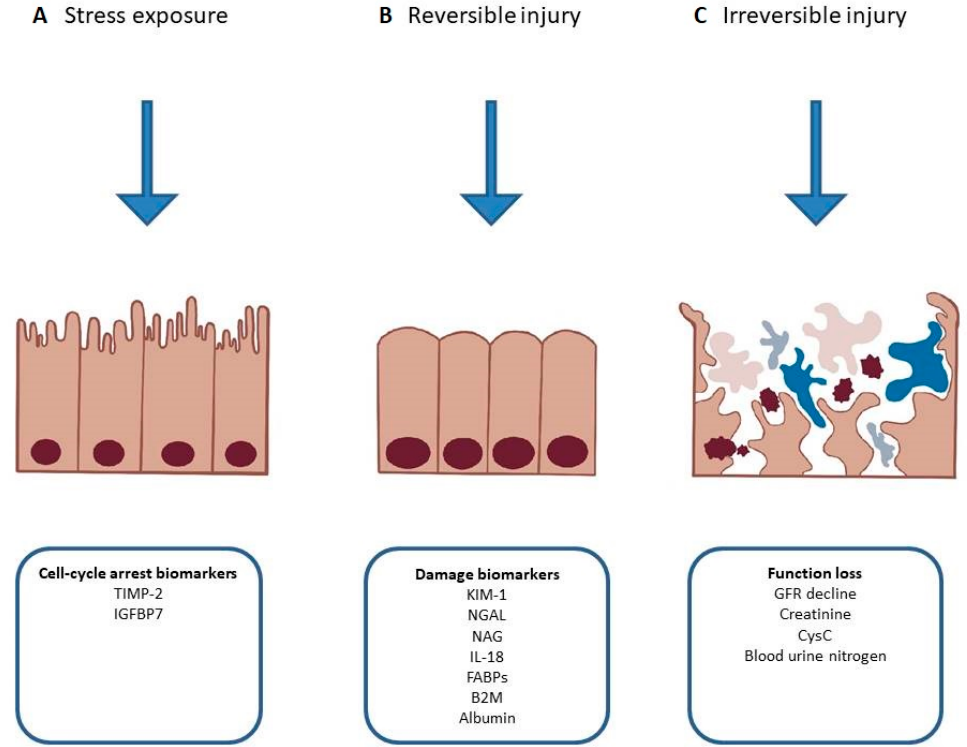
Figure 3. Phases of acute kidney injury and relevant biomarkers. ( A ) Release of cell-cycle arrest biomarkers in response to exposure to non-damaging stimuli. ( B ) Potentially reversible injury resulting in changed metabolism or expression of damage biomarkers. ( C ) Persistent injury resulting in necrosis, apoptosis and kidney dysfunction. TIMP-2—tissue inhibitor of metalloproteinase 2, IGFBP7—insulin-like growth factor-binding protein 7, KIM-1—kidney injury molecule 1, NGAL— neutrophil gelatinase-associated lipocalin, NAG— N -acetyl-ß-d-glucosaminidase, IL-18—interleukin-18, FABPs—fatty acid-binding proteins, B2M—beta-2 microglobulin, GFR—glomerular filtration rate, CysC—cystatin C.